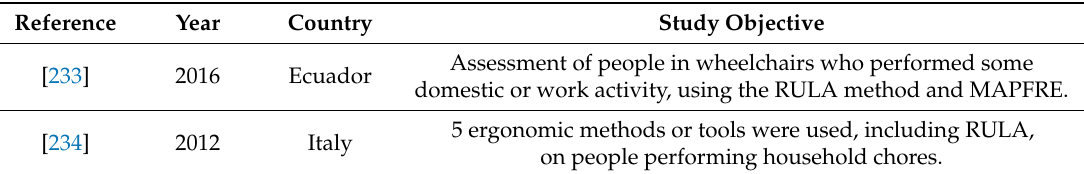
Table 20. Activities of households as employers; undi ff erentiated goods-and services-producing activities of households for own